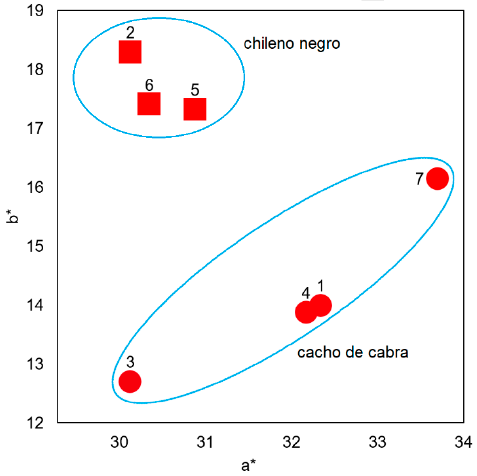
Figure 7. Relation of color parameters for chili pepper fruits from different fields belonging to two landraces. Color parameter a* represents bluish-green/red-purple hue component, and b* represents yellow/blue hue component. Symbol colors were generated using average field measurements.